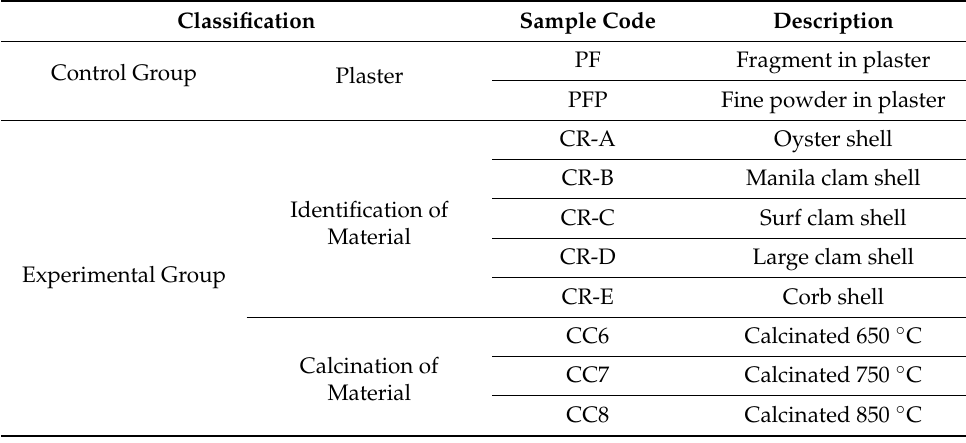
Table 1. Sample details: summary of sample description used during this